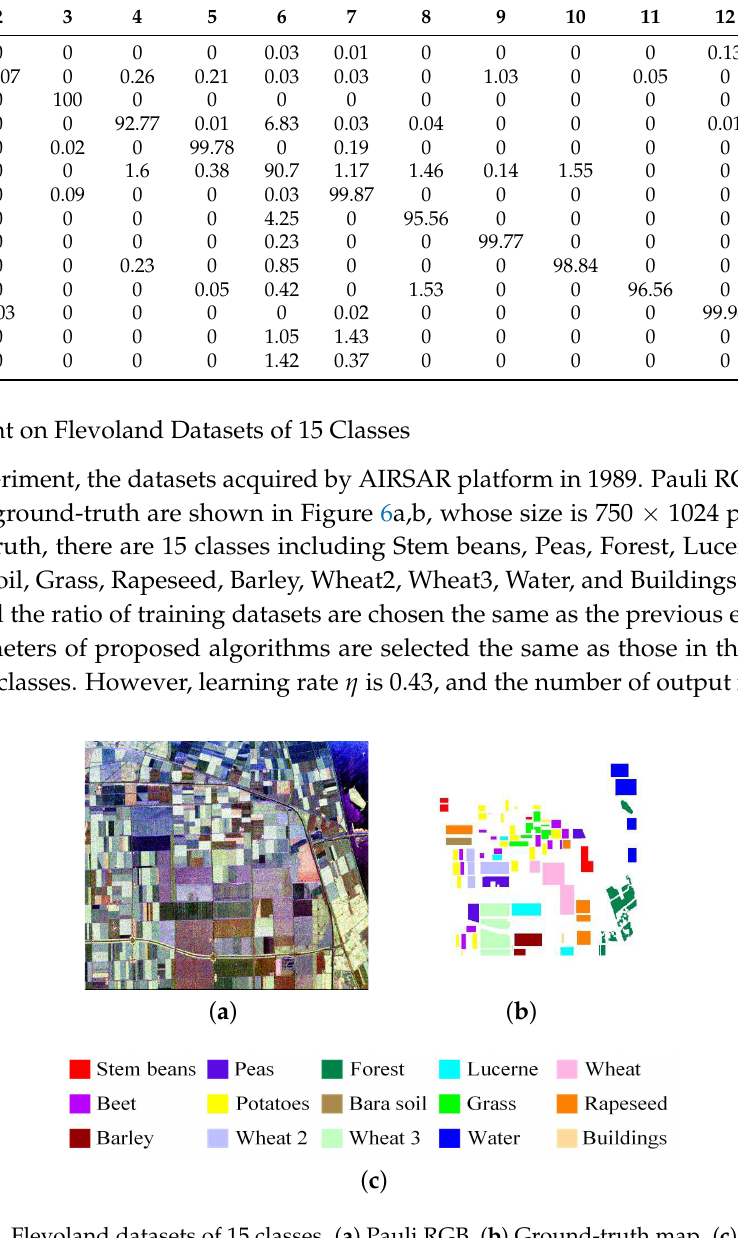
Figure 6. Flevoland datasets of 15 classes. ( a ) Pauli RGB. ( b ) Ground-truth map. ( c )